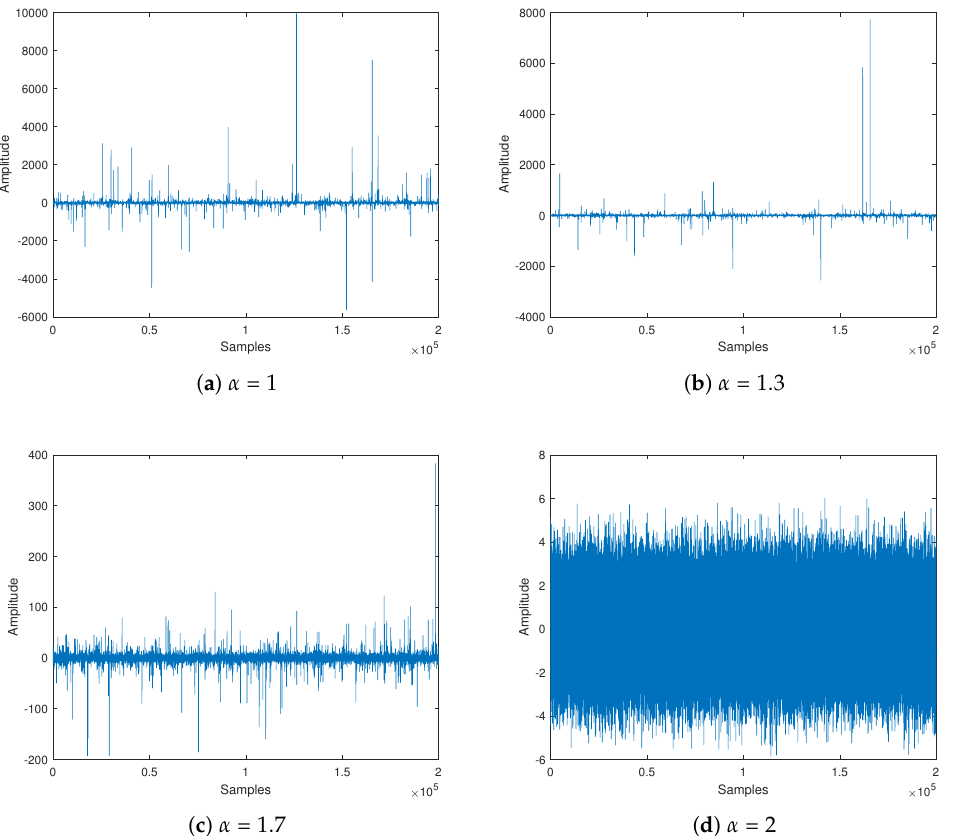
Figure 3. Sample time series of random variables with a symmetric α stable distribution for different α